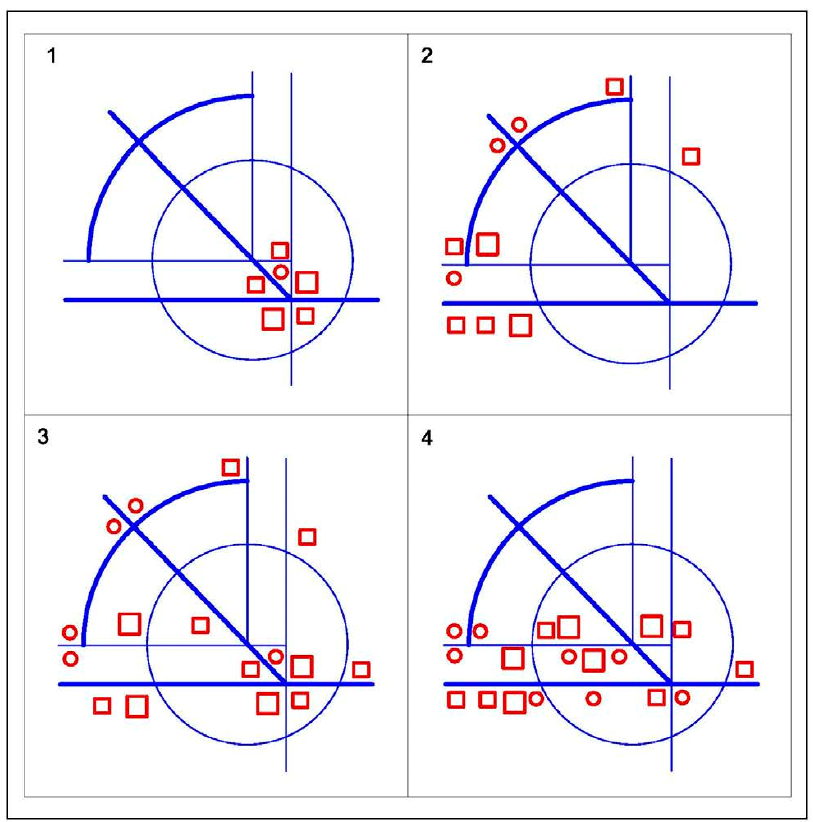
Figure 3. The location of business centers in the structure of the city: ( 1 ) concentrated; ( 2 ) peripheral; ( 3 ) dispersed; and ( 4 )